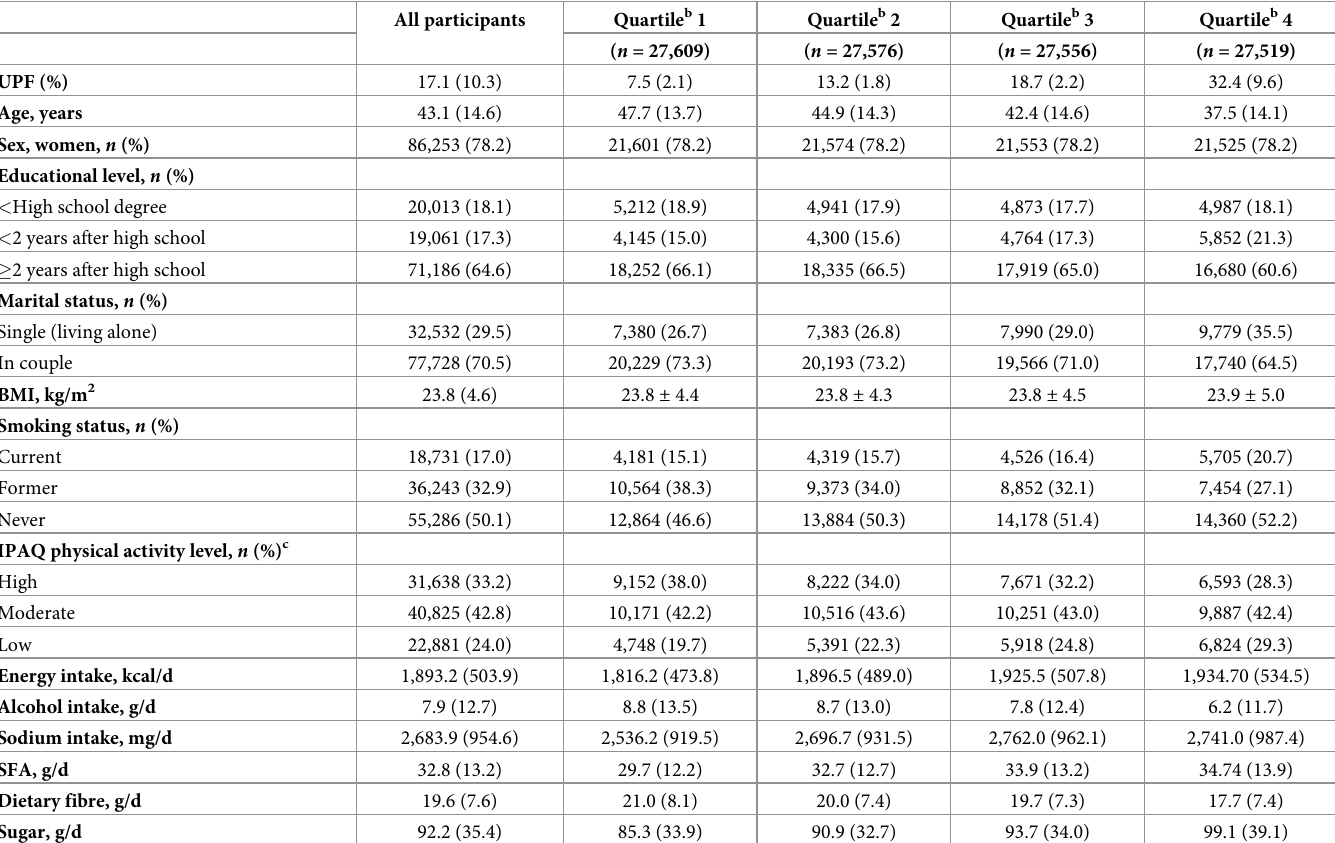
Table 1. Baseline characteristics of the study population according to sex-specific quartiles of UPF consumption ( N = 110,260), NutriNet-Sante´ cohort, France, 2009–2019 a